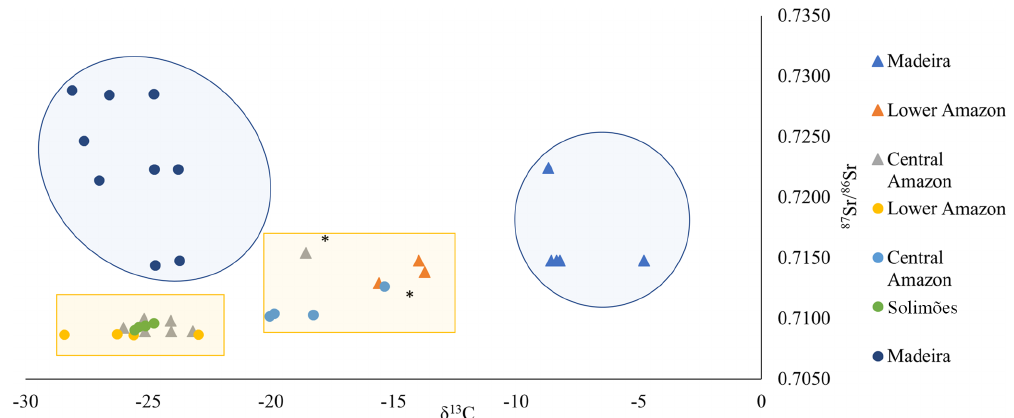
Figure 6. Biplot of mean δ 13 C and 87 Sr / 86 Sr for 38 wild (circle symbols) and farmed (triangle symbols) Arapaima otoliths from four geographic regions. Large blue shading represent farmed and wild fish from the Madeira, and yellow squares wild and farmed fishes from Lower Amazon, Central Amazon, and Solimões. The only two samples that are out of their group are tagged with ∗